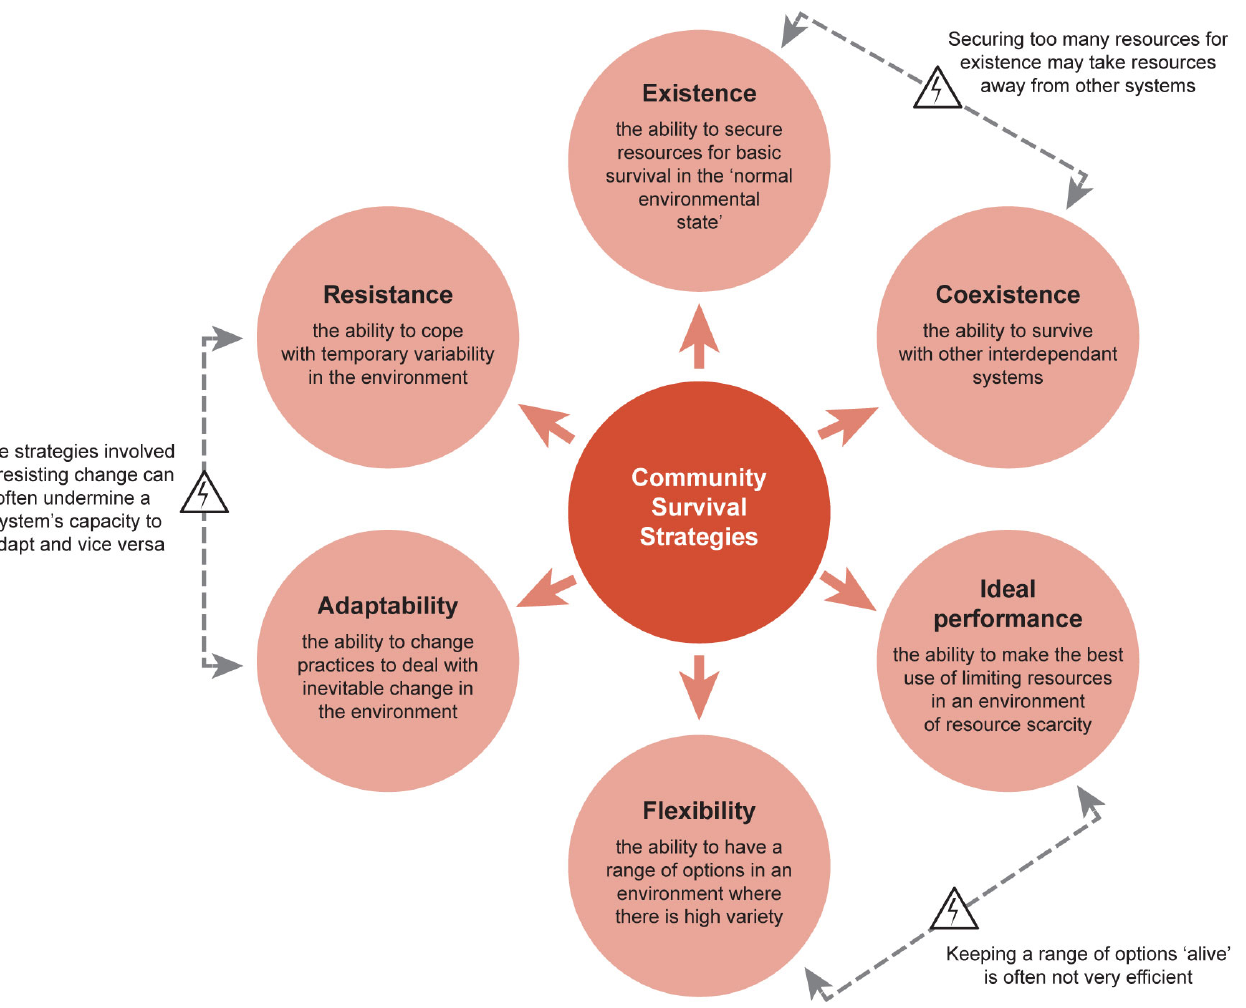
Fig. 1 . System viability